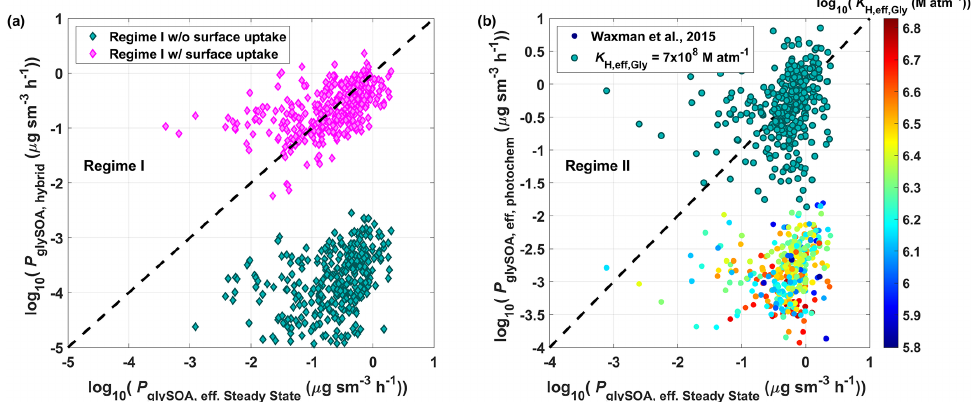
Figure 5. Comparison of glySOA production rate ( P glySOA ) between steady-state and hybrid analysis for (a) Regime I with (pink diamonds, γ Gly , uptake = 0 . 0098) and without (green diamonds) the surface uptake process. (b) Regime II with fixed K H , eff_Gly (7 . 0 × 10 8 Matm − 1 , green circles) and calculated K H , eff_Gly based on salting in by AN and AS following Waxman et al. (2015) (colored circles). Surface uptake process was not included in (b) .